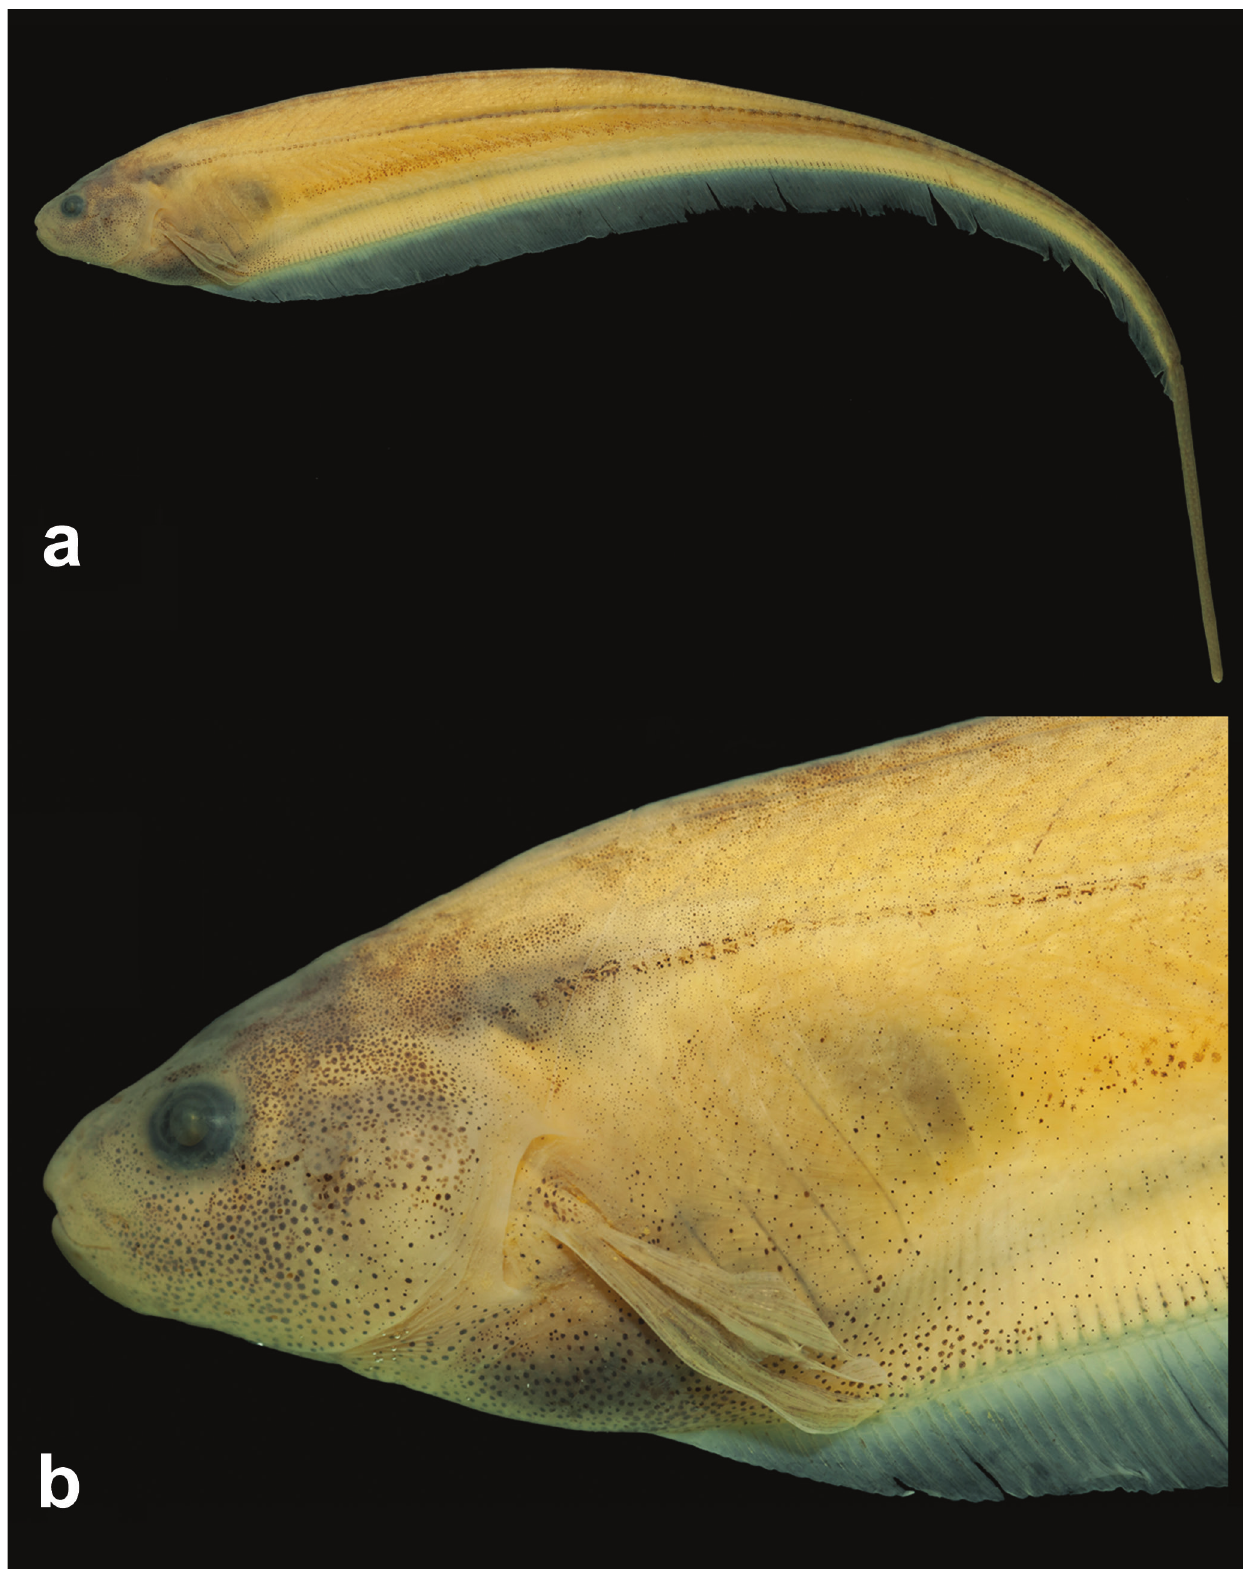
Fig. 1. Holotype of Eigenmannia sayona , new species, MZUSP 96497, 131.8 mm LEA, Venezuela, Bolivar, Cedeño, río Orinoco, río Parguaza, near the community of Puente Parhueña. a . Lateral view of head and body; b . Lateral view of